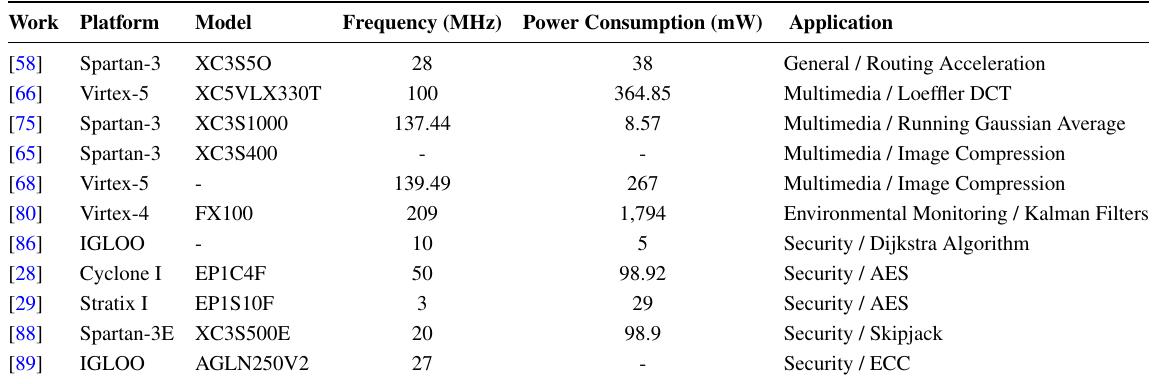
Table 8. FPGA coprocessors for research sensor